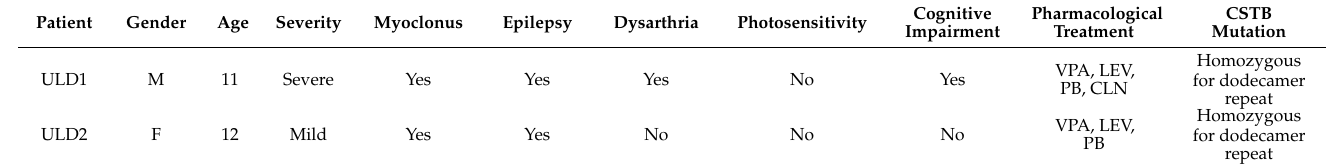
Table 1. Summary of the clinical features, treatment and genetic mutation of ULD1 and ULD2 patients.